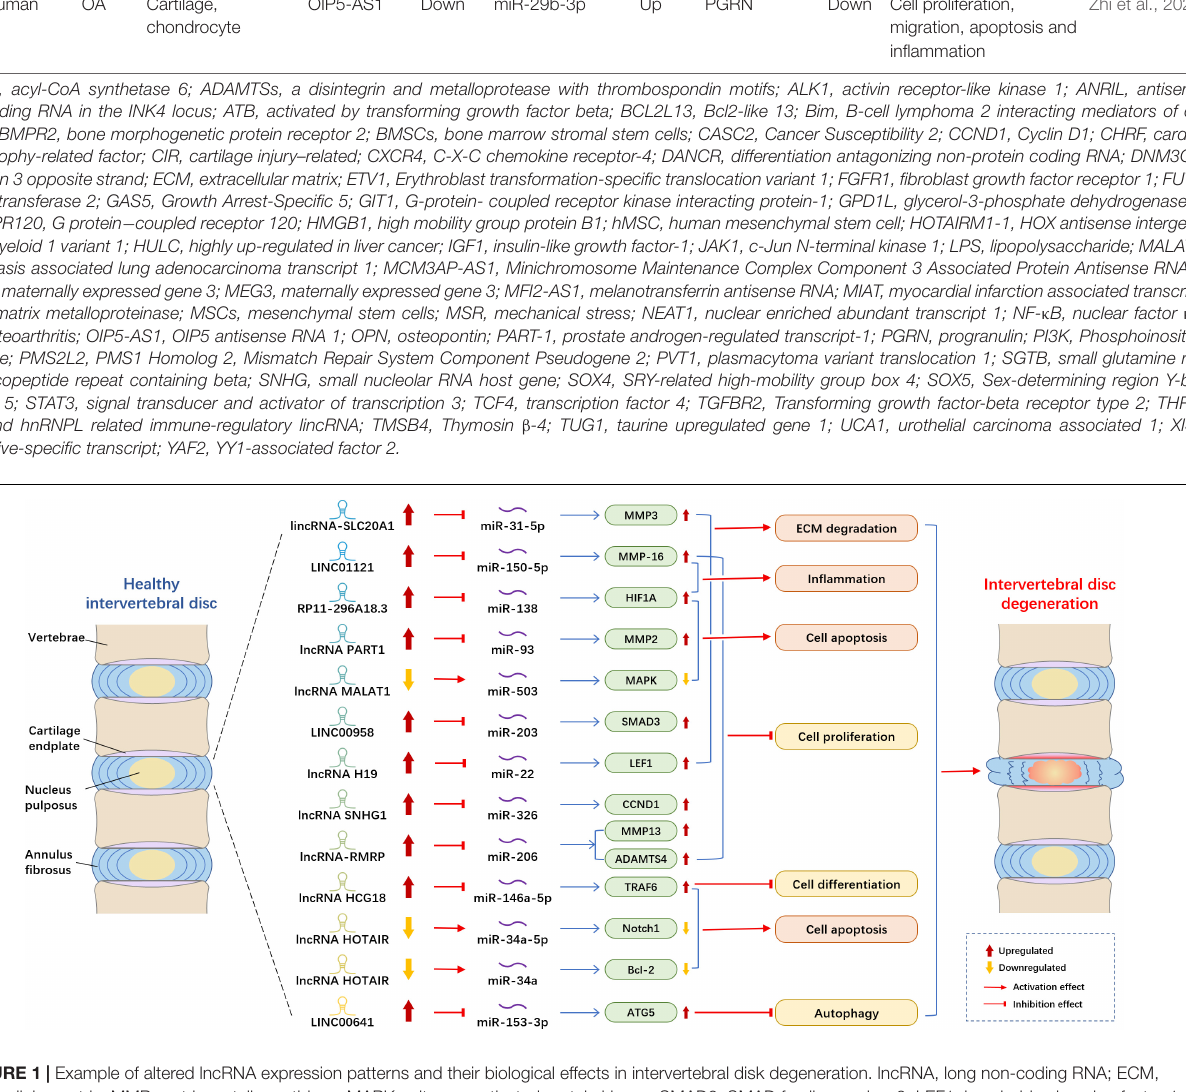
FIGURE 1 | Example of altered lncRNA expression patterns and their biological effects in intervertebral disk degeneration. lncRNA, long non-coding RNA; ECM, extracellular matrix; MMP, matrix metallopeptidase; MAPK, mitogen-activated protein kinase; SMAD3, SMAD family member 3; LEF1, lymphoid enhancing factor-1; CCND1, cyclin D1; ADAMTS4, A disintegrin and metalloproteinase with thrombospondin motifs 4; TRAF6, tumor necrosis factor receptor-associated factor 6; Notch1, Notch Receptor 1; Bcl-2, B cell lymphoma 2; ATG5, autophagy-related gene